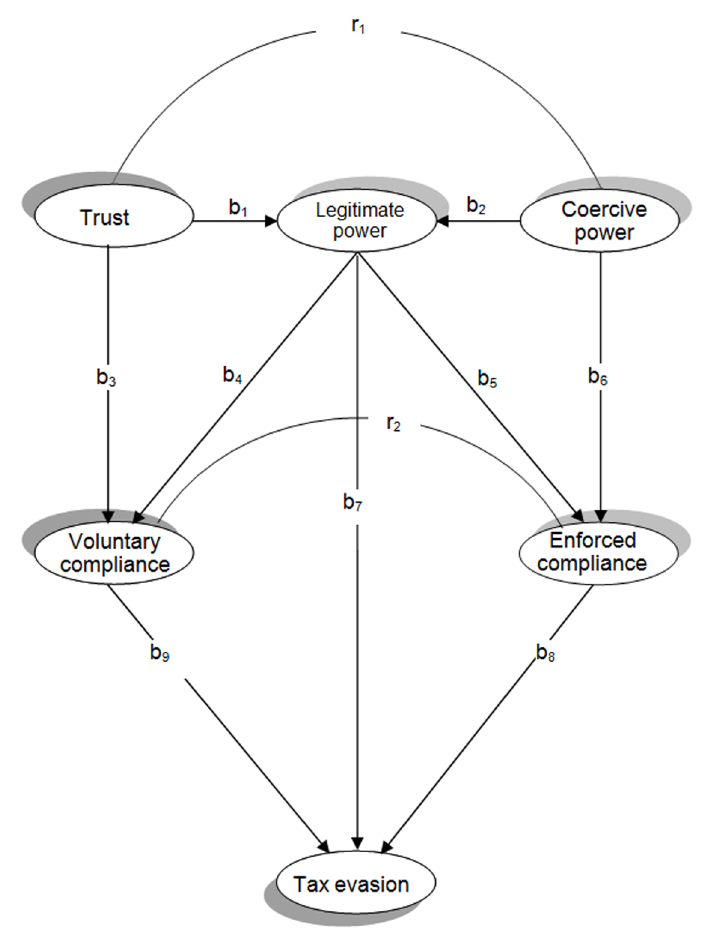
Figure 1. Structure of the extended version of the slippery slope framework (Kastlunger et al.,